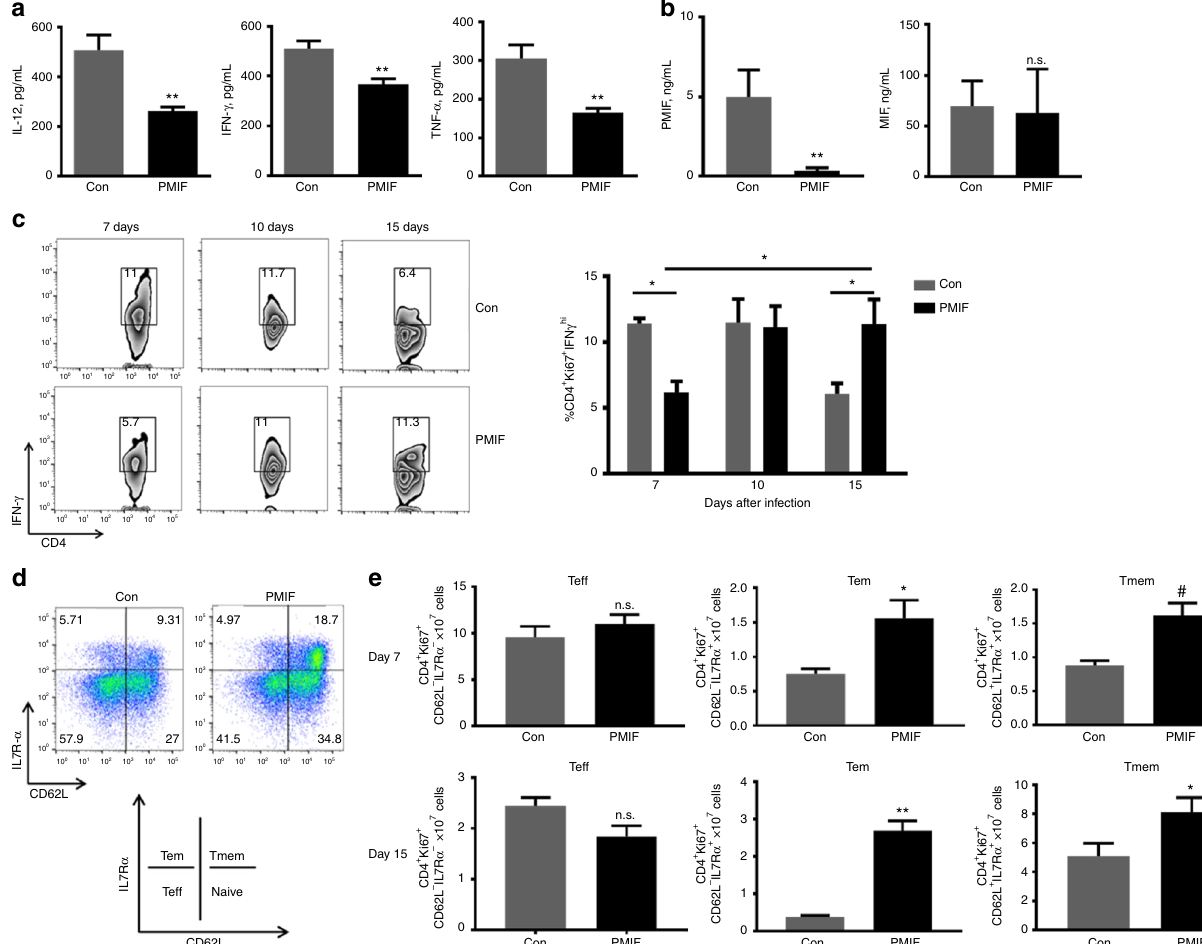
Fig. 5 PMIF neutralization decreases in fl ammatory cytokine production and enhances the development of CD4 T cells into effector memory and memory precursors during blood-stage infection. a , b Serum levels of the indicated cytokines were detected by speci fi c ELISA 7 days after injection of 10 6 Pb AWT iRBCs in mice immunized with RNA replicons encoding Con RNA or PMIF RNA. Data are representative of two independent experiments. Bars represent the mean of 6 mice ± SD; * p < 0.05,** p < 0.01 by Mann – Whitney test. c On day 7, 10, and 15 after infection, splenocytes were isolated and stimulated ex vivo with iRBC lysates in the presence of Brefeldin A. Representative dot plots and frequencies of Pb AWT responsive CD4 T cells (Ki67 + CD4 + ) expressing IFN- γ in spleens was detected by intracellular staining and analyzed by fl ow cytometry. Data are representative of two independent experiments. Bars represent the mean of 10 mice ± SD; * p < 0.05 by Mann – Whitney test. d , e Numbers of Pb AWT responsive CD4 T cell (Ki67 + CD4 + ) subsets, including T effector (Teff): CD62L − IL7R α − , T effector memory (Tem): CD62L − IL7R α + , and T memory (Tmem): CD62L + IL7R α + at day 7 and 15 after infection. The contribution of each memory CD4 T cell subset is expressed relative to the total number of Pb AWT responsive CD4 T cells. Data are representative of two independent experiments. Bars represent the mean of 10 mice ± SD; n.s.: non-signi fi cant, * p < 0.05, ** p < 0.001, # p < 0.0001